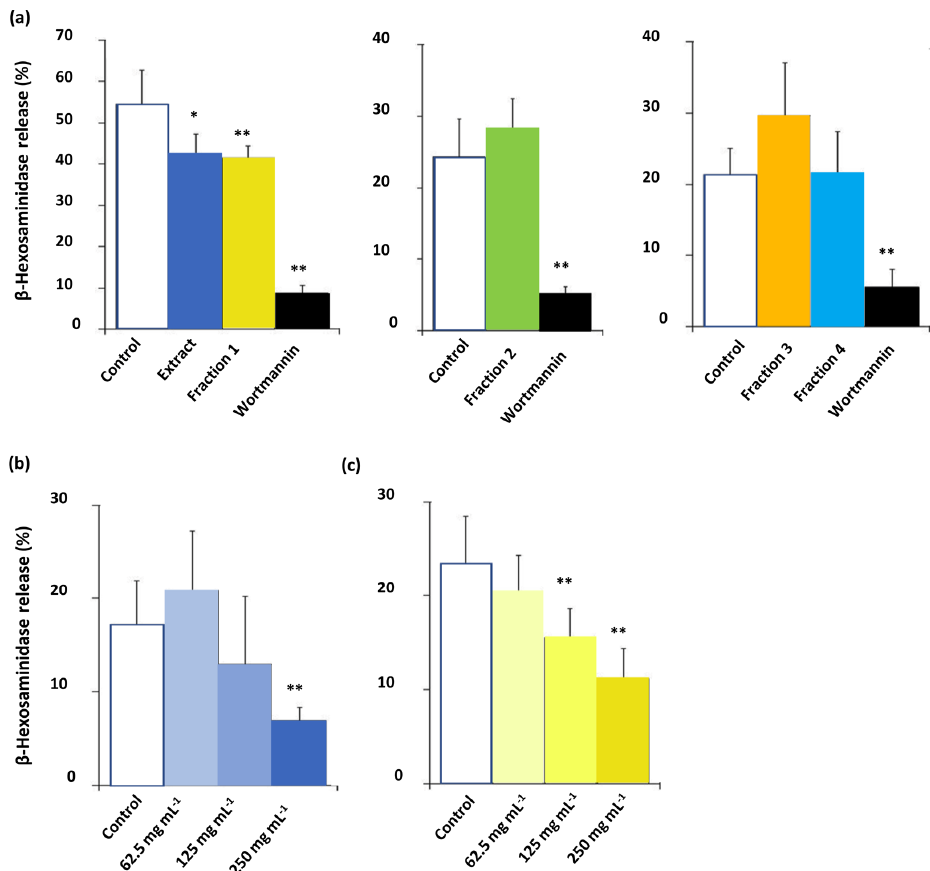
Figure 5. β -Hexosaminidase release inhibitory activity of ( a ) a green Cyclopia subternata hot water extract and four fractions from large-scale fractionation on XAD 1180N at 250 µg/mL and ( b ) the extract and ( c ) fraction 1 at three concentrations (62.5, 125 and 250 µg/mL). * and ** indicate significant differences versus the control at p < 0.05 and p < 0.01, respectively.